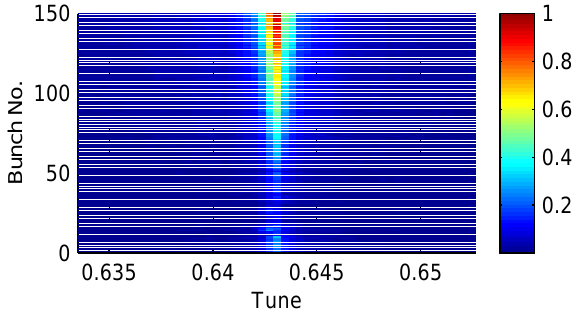
FIG. 2. (Color) Color-coded representation of magnitude spec- tra of the 150 bunches in Fig. 1. Peaks of Fourier transform of bunch transients lie at the same tune, indicating that tune spread across the train is # the frequency resolution (50 Hz).